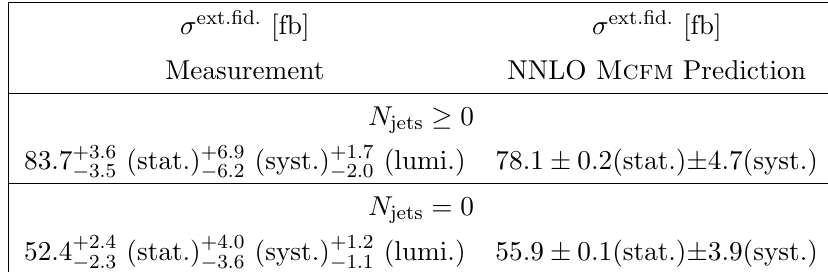
Table 6 . Measured cross sections for Z ( (cid:23) (cid:22) (cid:23) ) (cid:13) production within the extended (cid:12)ducial region for a centre-of-mass energy of p s = 13 TeV, with corresponding SM expectations obtained from the Mcfm [47] generator at next-to-next-to-leading order in the strong coupling constant (cid:11)